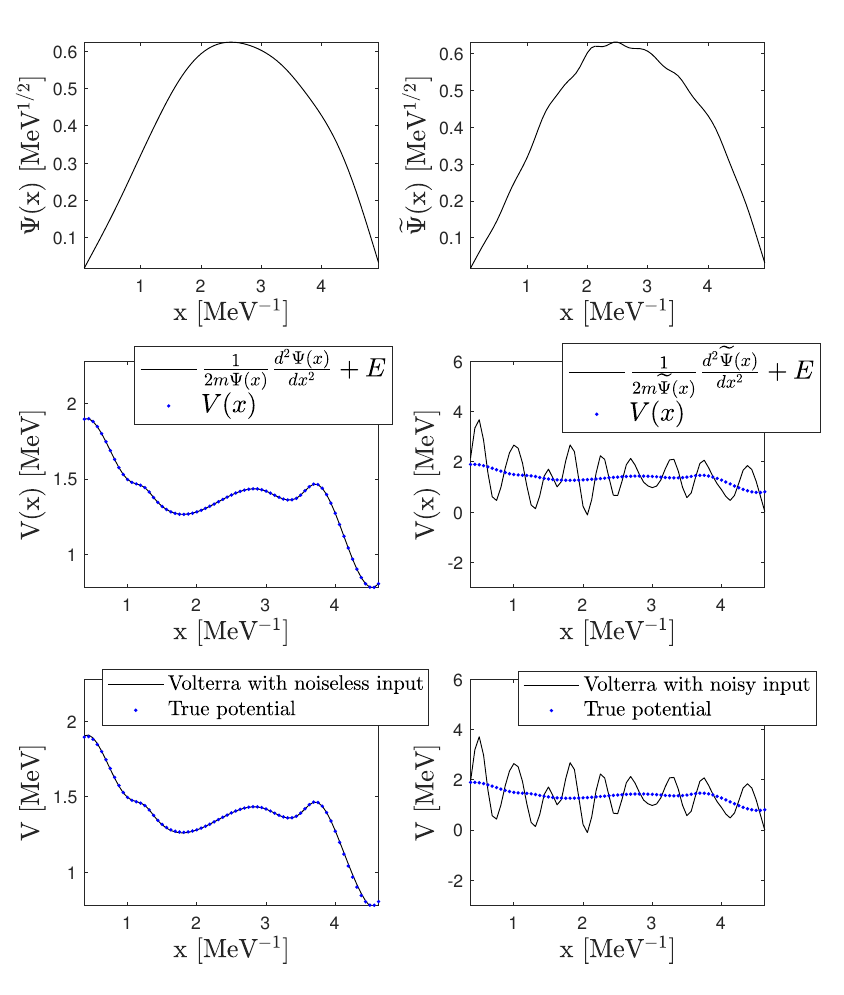
Figure 14. Output sensitivity test for the inverse bound state problem, with an additive band-limited Gaussian noise on the input wave function (cid:101) Ψ ( x ) = Ψ ( x ) + n Ψ ( x ) . The left side shows a noiseless case, while the three figures in the right column show the noisy results. The upper two figures show the noiseless and noisy input wave functions, the middle two figures show the results of the true dynamical model, while the bottom two figures show the results obtained by the Volterra model for the noiseless and for the noisy case,